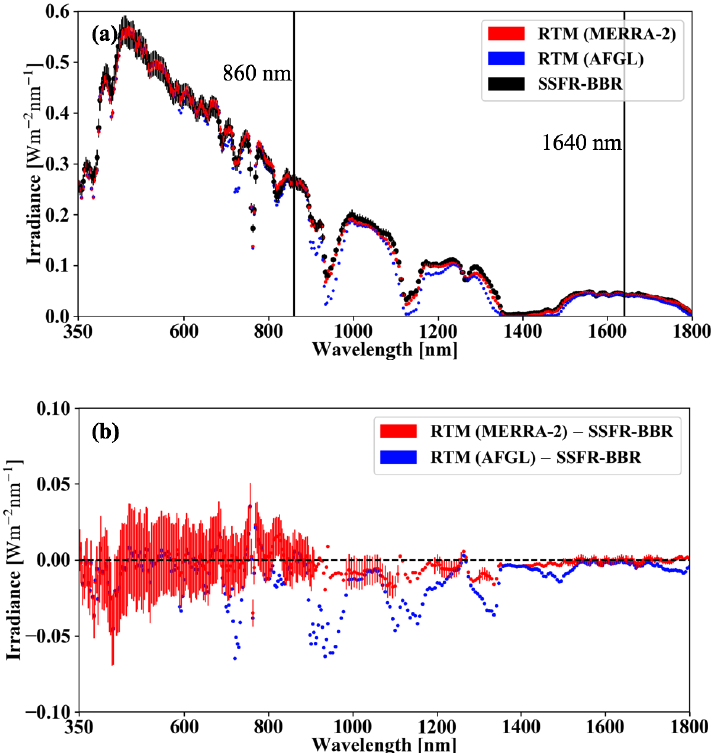
Figure 12. (a) Spectral upwelling irradiance from SSFR–BBR (black) and MODIS COPs RTM calculations with atmospheric profiles from MERRA-2 (red) and with AFGL subarctic summer climatology (blue) at 21:24UTC on 11 September. (b) Irradiance difference between RTM and SSFR–BBR. The uncertainty of the SSFR–BBR irradiance is indicated as error bars (for one spectrum